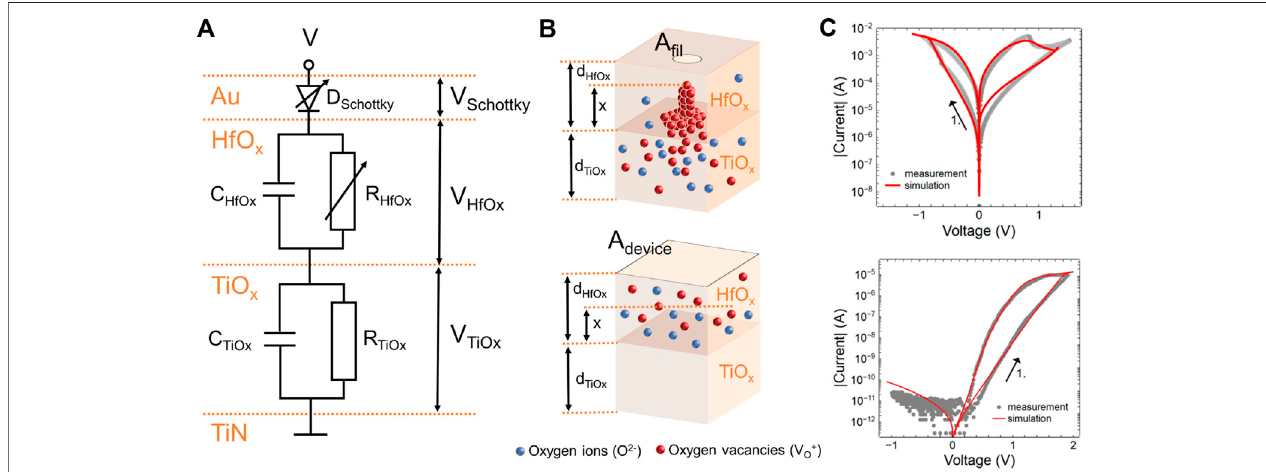
FIGURE 2 | (A) Sketch of the physics based device model for TiN/TiO x /HfO x /Au memristive devices. The model consists of two RC elements in the TiO x and HfO x layers and a Schottky diode at the interface of HfO x and Au top-electrode. The external source voltage is divided into three local voltage drops at the HfO x , TiO x layers, and the Schottky diode. (B) Two different resistive switching mechanisms of type F devices (top) and type R devices (bottom) are considered. While in type F devices oxygen vacancies form a fi lamentary conductive path in the HfO x fi lm under an external voltage, in type R devices oxygen ions in the HfO x fi lm drift toward the top metal-electrode. As a result, in both device types the changed ion concentration leads to a modulation of the Schottky barrier height, which leads to the switching behaviors.HerebyoriginatesthedifferenceintheswitchingmechanismsfromthedensityoftheoxygenvacanciesintheHfO x fi lm. (C) MeasuredI-Vcurves(gray)andthe simulation results (red) for type F (top) and type R (bottom) devices. The arrows point to the SET